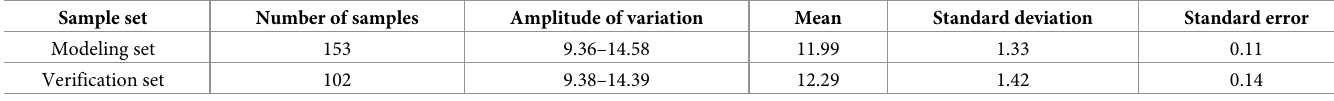
Table 2. Distribution of winter wheat GPC in the modeling and verification set (GPC unit: %). Sample set